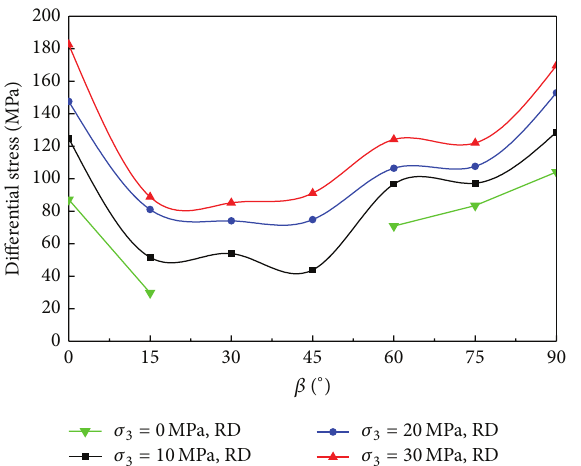
Figure 5: Differential stress at failure ( 𝜎 1 − 𝜎 3 ) versus 𝛽 at different confining pressures ( 𝜎 3 ).